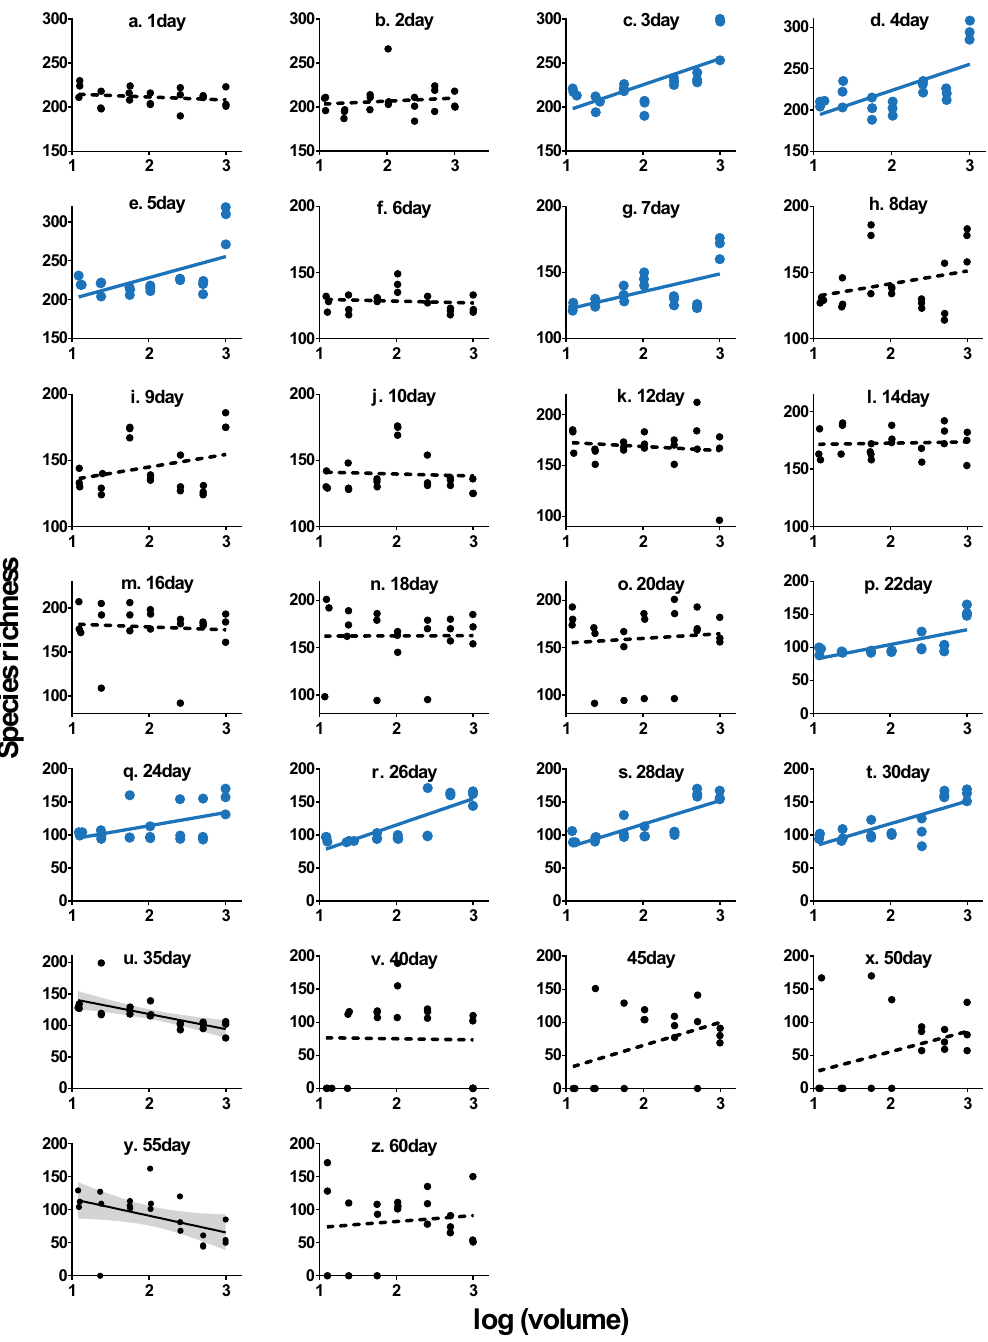
Figure 2. Microbial SAR at 60 days in the microcosm system. The regression line is from a linear model (volume is normally converted to the log scale). A solid line indicates a significant correlation, and a dashed line indicates that the correlation is not significant. A blue band represents the 95% confidence interval of a positive SAR, and a grey band represents the 95% confidence interval of a negative SAR (see Supplementary Table 1 for linear regression